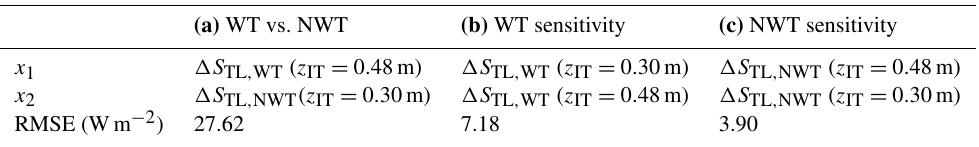
Table A1. Using root-mean-squared errors (RMSEs) calculated with Eq. (A1) for the comparison of mean diurnal variations in energy storage change in the thawed layer ( (cid:49)S TL ) over the whole measuring period between parameters x 1 and x 2 . (a) Comparison between WT (water track) and NWT (non-water track) values with measured ice table depths ( z IT ). (b) Sensitivity of (cid:49)S TL to different z IT values at WT, where measured z IT is assigned to x 2 . (c) Same as (b) , but for